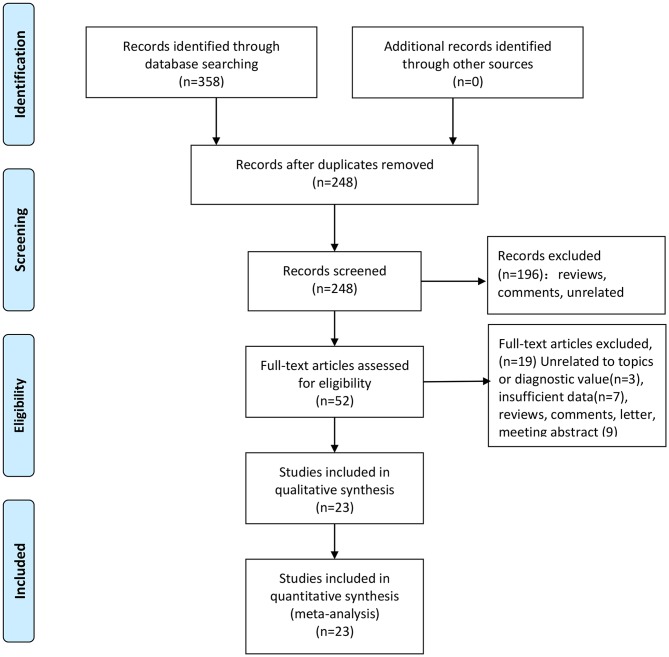
Flow chart of literature selection.